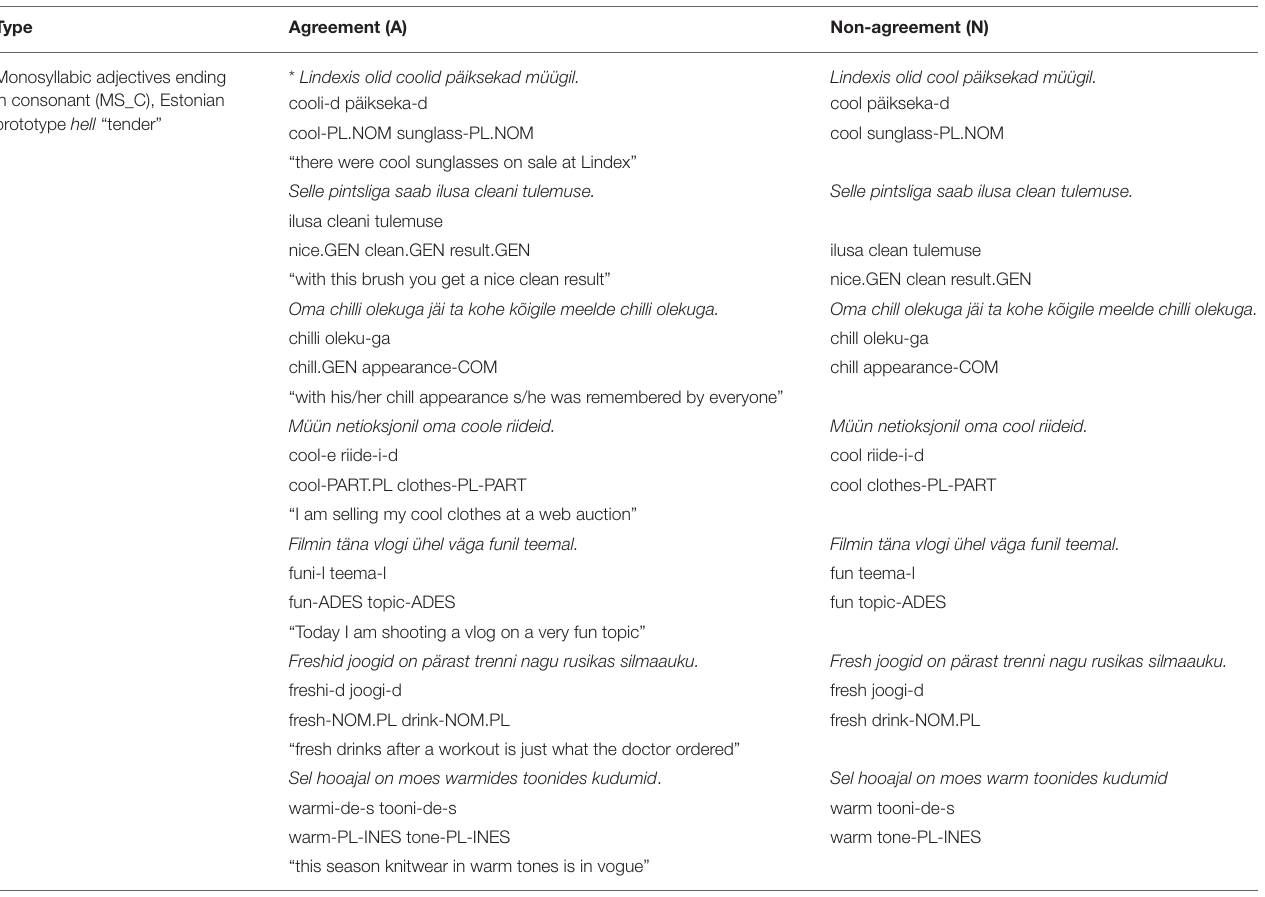
TABLE 2 | Test sentence examples for monosyllabic consonant-ending adjectives in the agreement (A) and the non-agreement (N) conditions. Type Agreement (A) Monosyllabic adjectives ending in consonant (MS_C), Estonian prototype hell